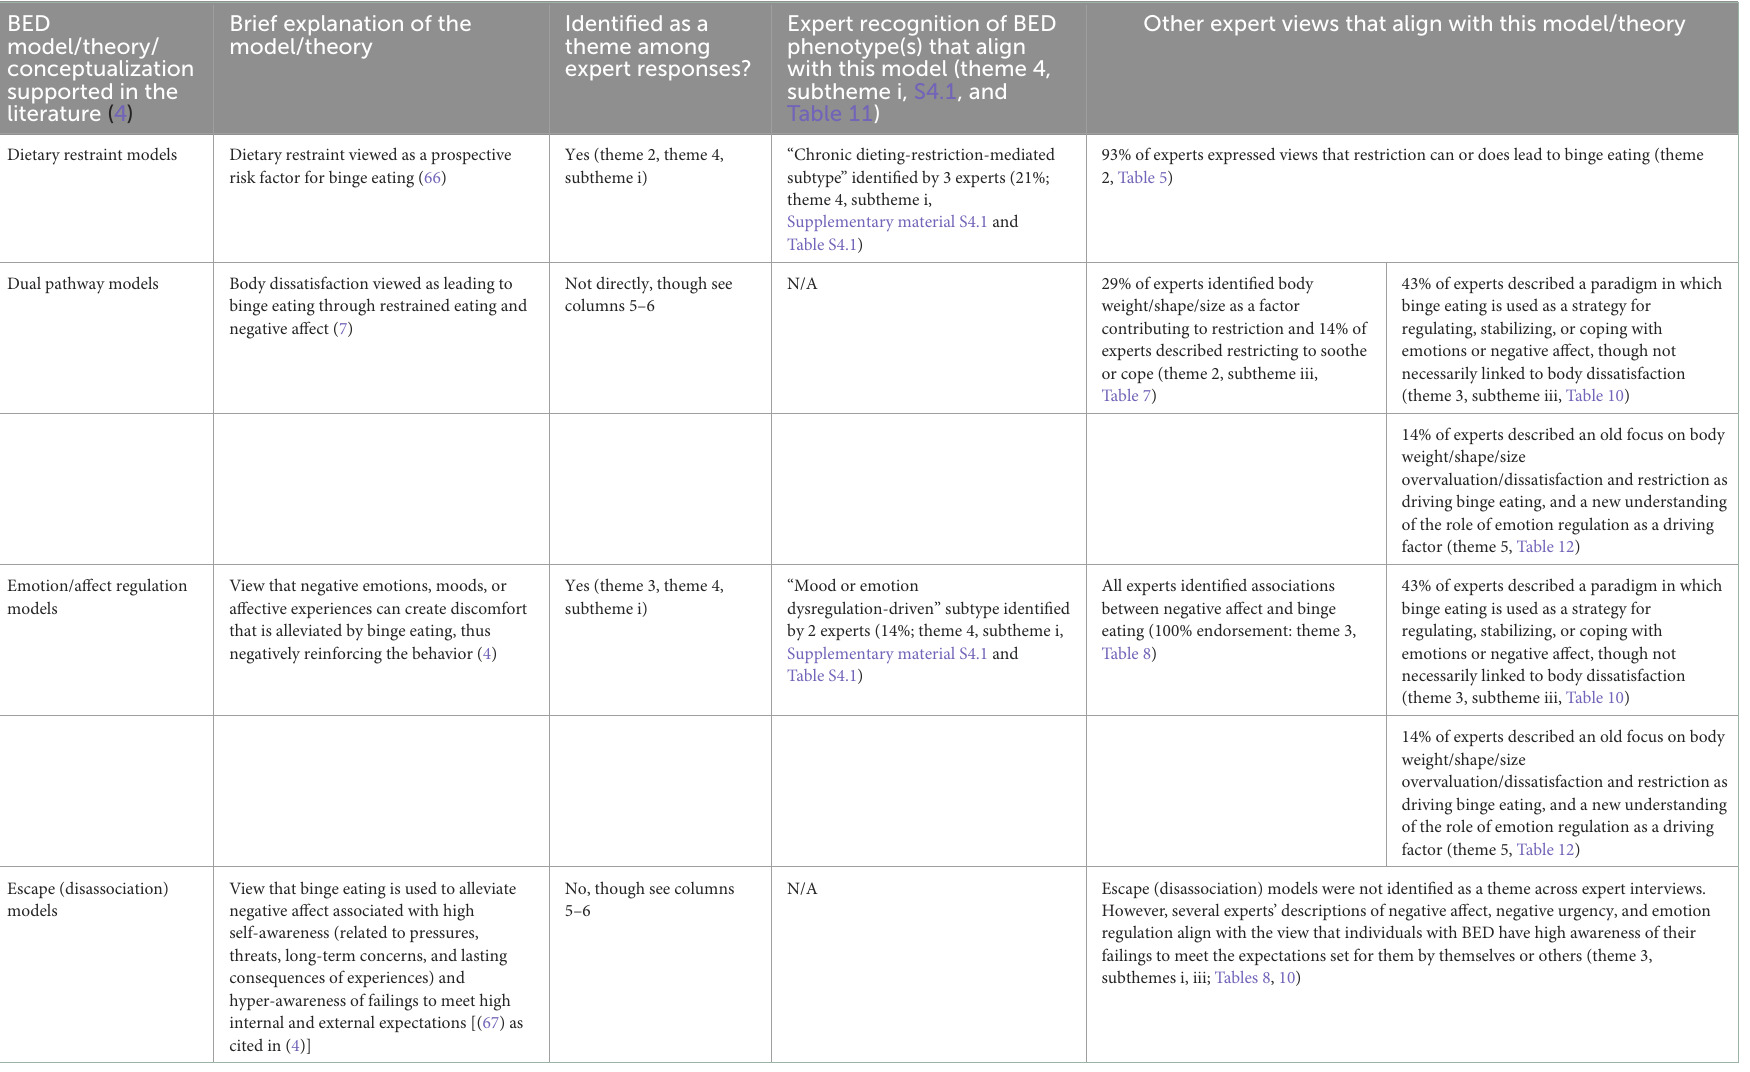
TABLE 14 Binge eating disorder models/theories/conceptualizations supported in the literature and participant statements that align with each theory/model/conceptualization. BED model/theory/